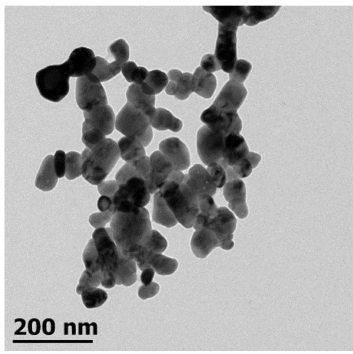
Figure 4. Illustrative transmission electron microscopy (TEM) image of synthesized ZnO